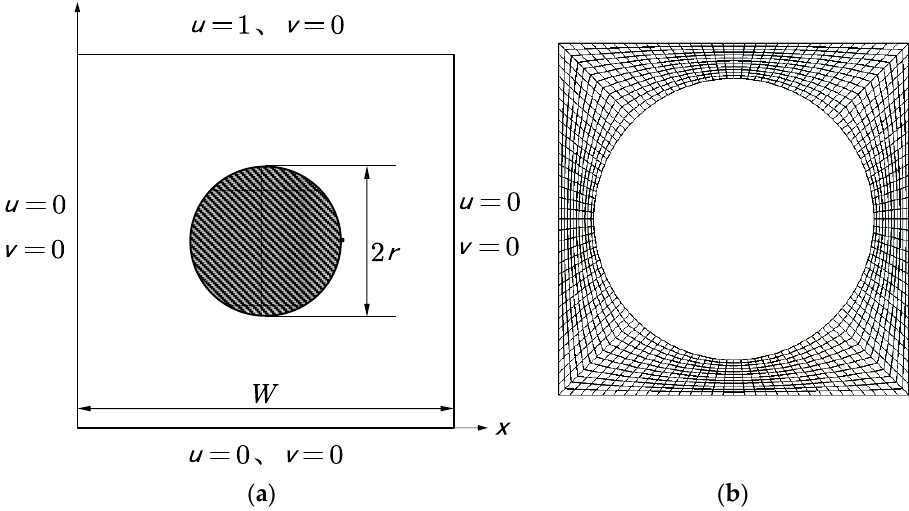
Figure 1. The lid-driven square cavity flow with an embedded circular obstacle. ( a ) Model ( b ) Meshes.